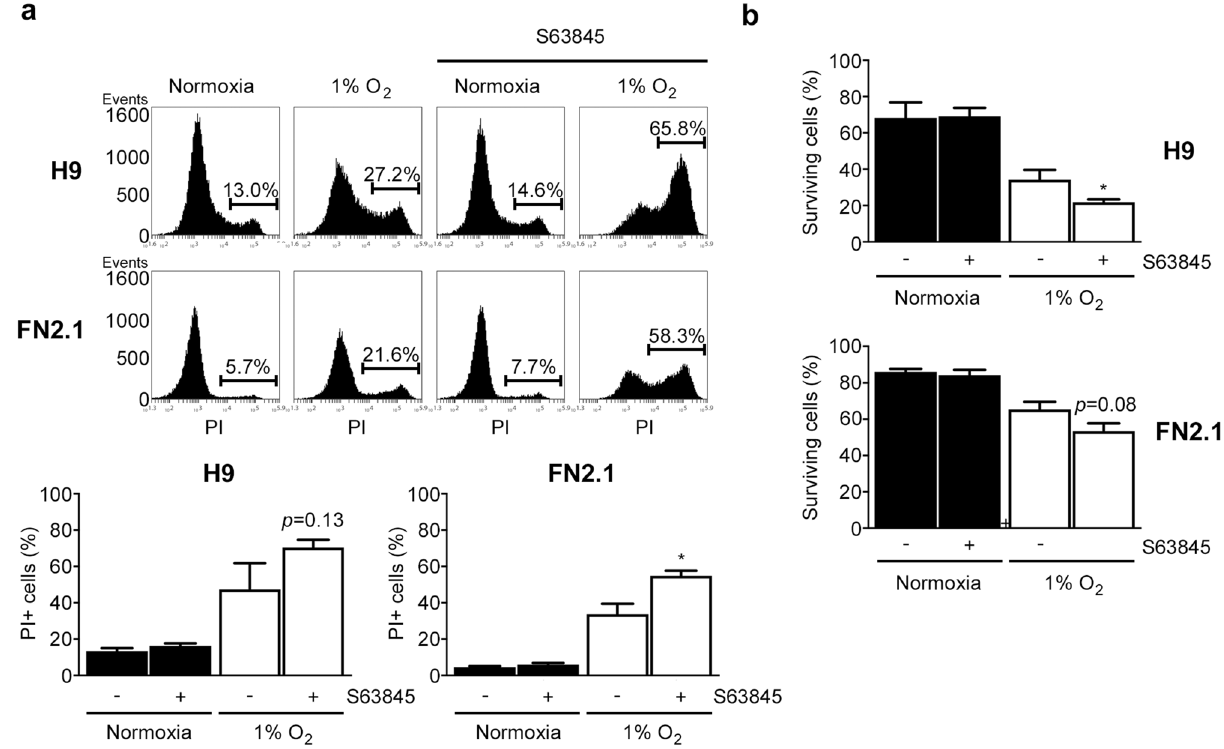
Figure 6. MCL-1 involvement in 1% O 2 hypoxia-mediated hPSCs cell death . ( a ) Representative histograms of Propidium iodide (PI) stained H9 and FN2.1 unfixed cells treated for 24 h with 1% O 2 in the presence or not of MCL-1 inhibitor S63845 (50 nM). The percentage of PI-positive cells (late apoptotic or necrotic) was determined by flow cytometric analysis. Mean + SEM from three independent experiments is graphed. Statistical analysis was done by Student’s t-test, (*) p < 0.05 vs. normoxia. ( b ) Bar graphs show the percentage of H9 and FN2.1 surviving cells assessed by Trypan blue exclusion method 24 h after 1% O 2 incubation in the presence or not of MCL-1 inhibitor S63845 (50 nM). Mean + SEM from three independent experiments is shown. Statistical analysis was done by Student’s t-test, (**) p < 0.01 and (***) p < 0.001 versus